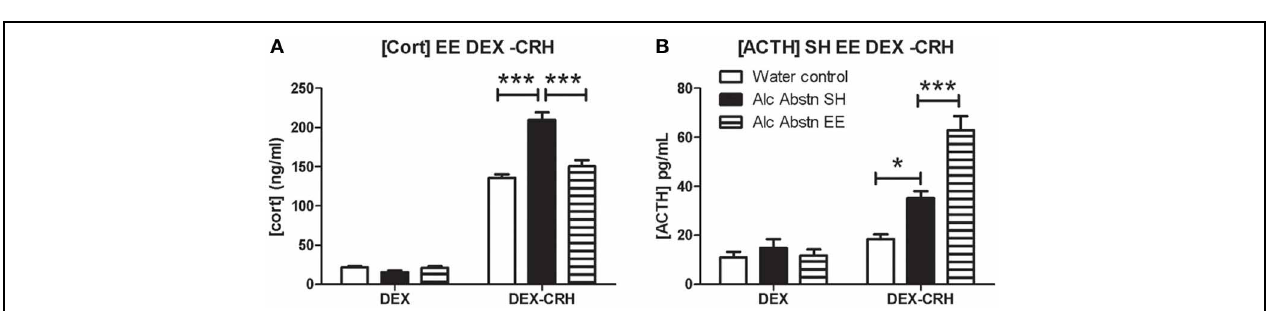
FIGURE 3 | Environmental enrichment modifies DEX-CRH response of alcohol abstinent mice. (A) Serum corticosterone levels did not differ between the groups in the DEX challenge. In the DEX-CRH challenge, Alc Abstn mice had significantly higher levels of corticosterone compared to water controls and the environmentally enriched abstinent mice. (B) The three groups had similar ACTH levels following the DEX challenge.